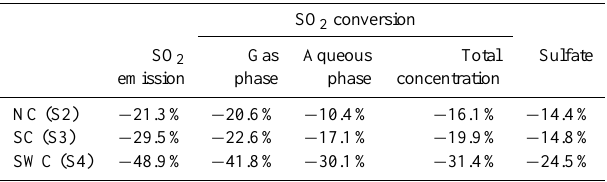
Table 3. Percentage changes of SO 2 conversion to sulfate and sul- fate concentration over NC, SC, and SWC in response to within- region SO 2 emission